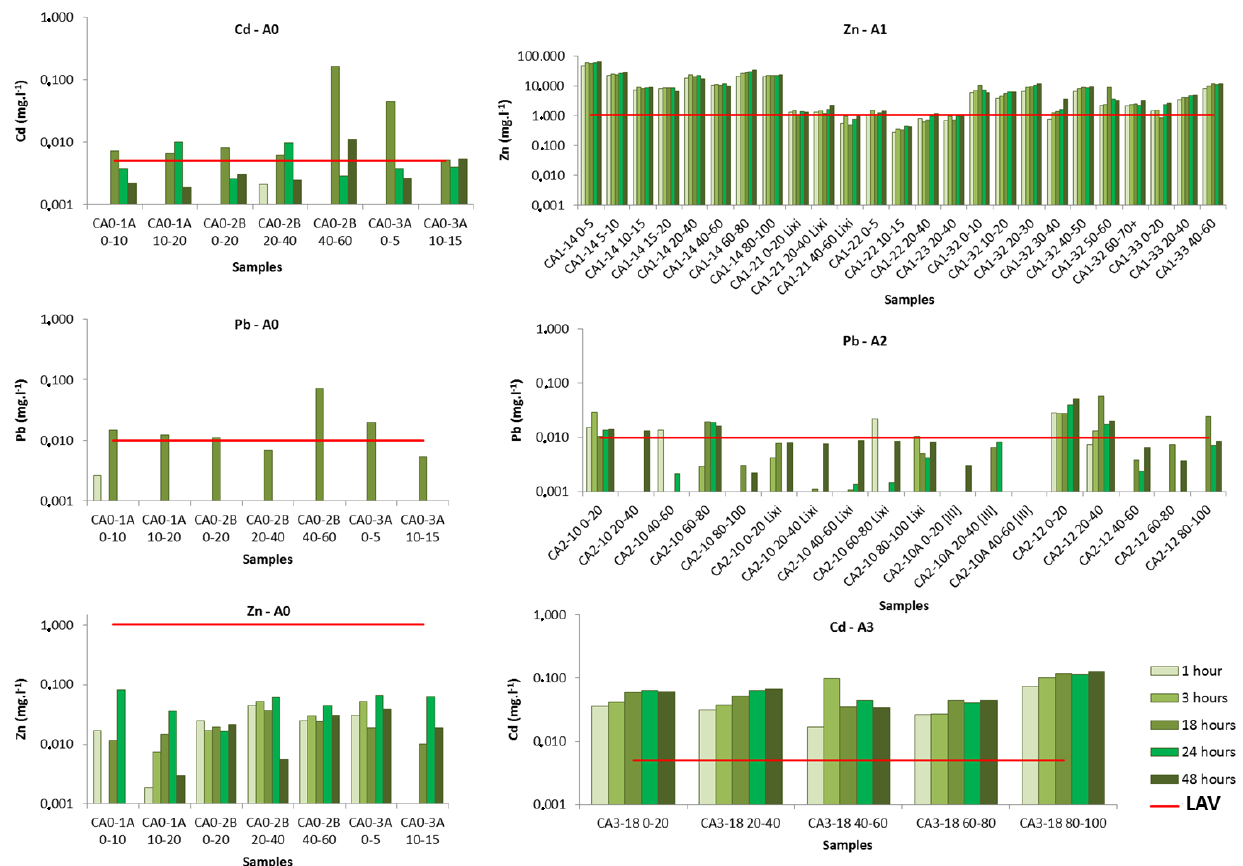
Figure 5. Concentrations of Cd, Pb, and Zn in the leachates resulting from the sediments leaching after 1 h, 3 h, 18 h, 24 h, and 48 h of stirring; The red line represents the legislated LAV for groundwater [22]; Samples with designation [III] correspond to the rainy season.